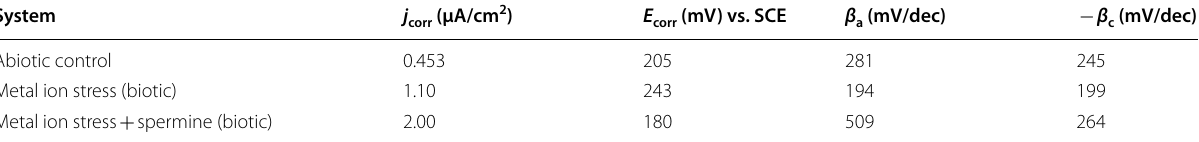
Table 2 Tafel parameters from Tafel scans in Fig. 7 (data from [Liu et al. 2022])